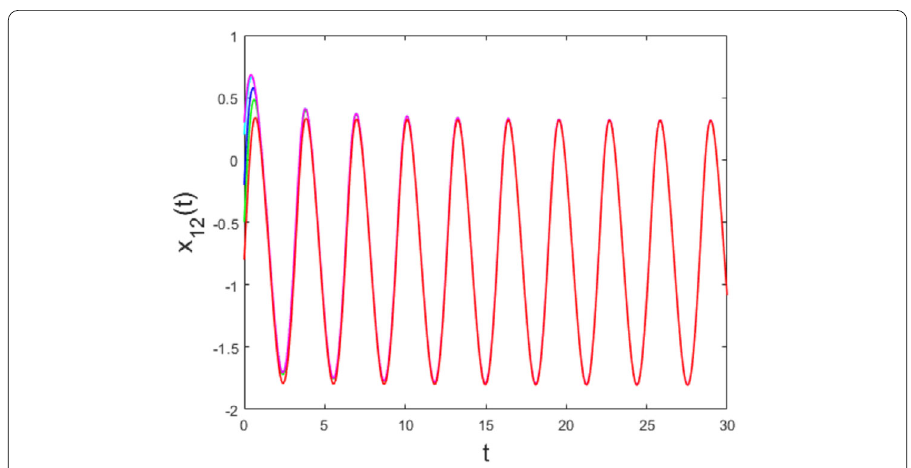
Figure 2 The state trajectory x 12 ( t ) of the network (11) with the initial conditions x